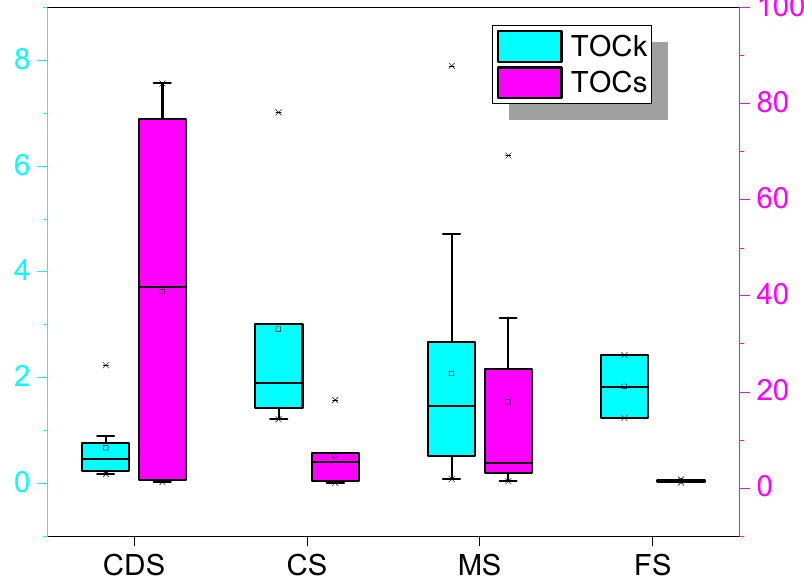
Figure 10. The kerogen organic carbon (TOCk) and the proportion of organic carbon in soluble OM to TOC of different lithofacies show that MS has a stronger hydrocarbon generation capacity than CDS. TOCk = TOC − 0.83 × extracts [48]. TOCs = 0.83 × extracts/TOC × 100%.